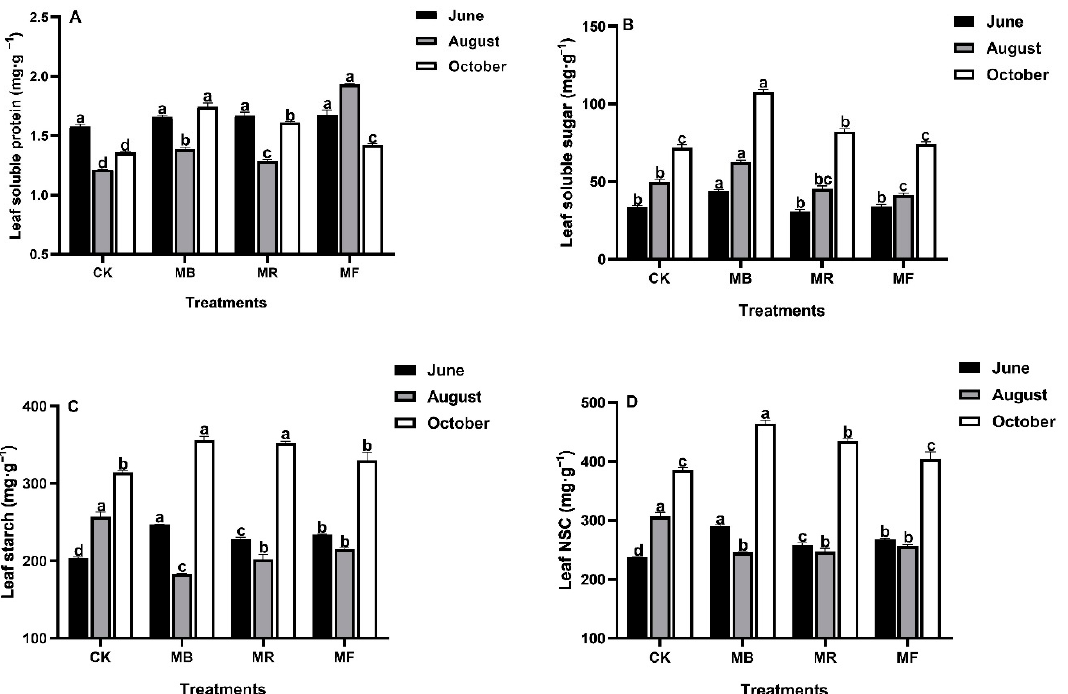
Figure 3. The effect of mulch treatments on leaf soluble protein content and carbohydrate contents, where MB: bamboo leaves mulch, MR: rice husks mulch, MF: organic fertilizers mulch, and CK: control. ( A ) Leaf soluble protein; ( B ) Leaf soluble sugar; ( C ) Leaf starch; ( D ) Leaf non-structural carbohydrate (NSC). Various letters on each bar show significant differences ( P < 0.05) with vertical bars as standard errors ( n =